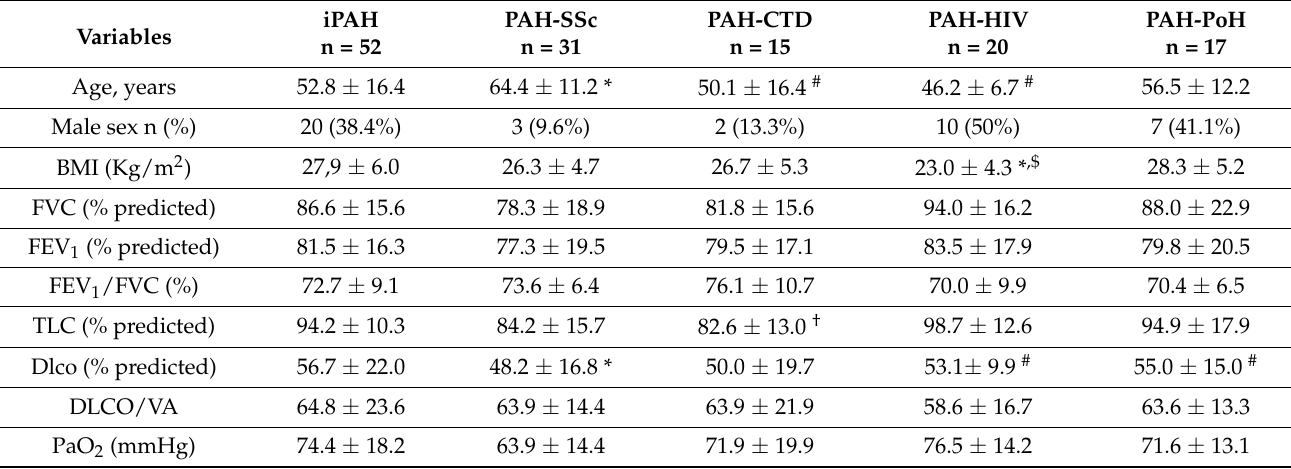
Table 2. Clinical characteristics of patients with the different subtypes of pulmonary arterial